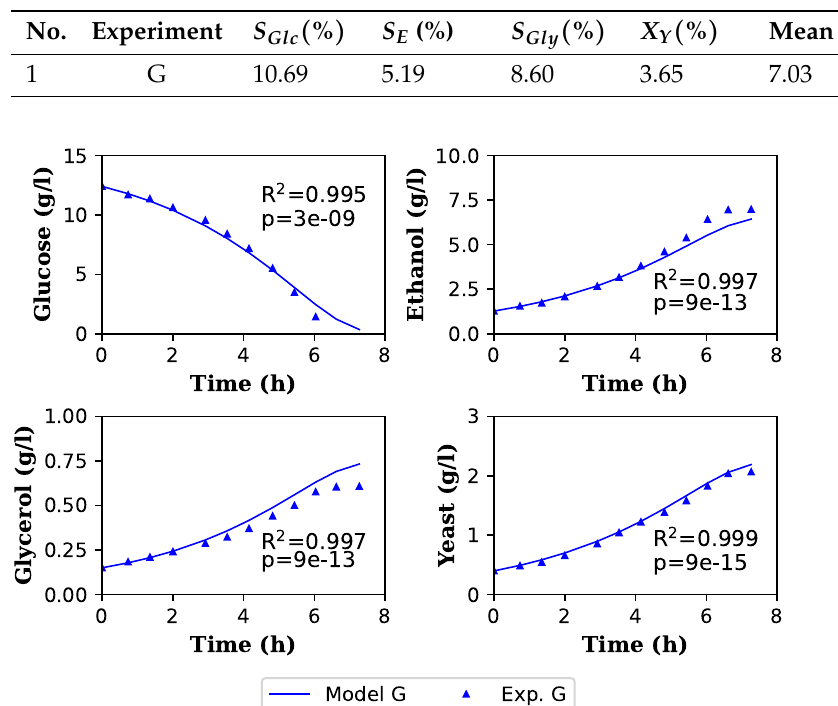
Figure 8. Model validation: yeast activity simulation without gas injection. Comparison between model output and experimental